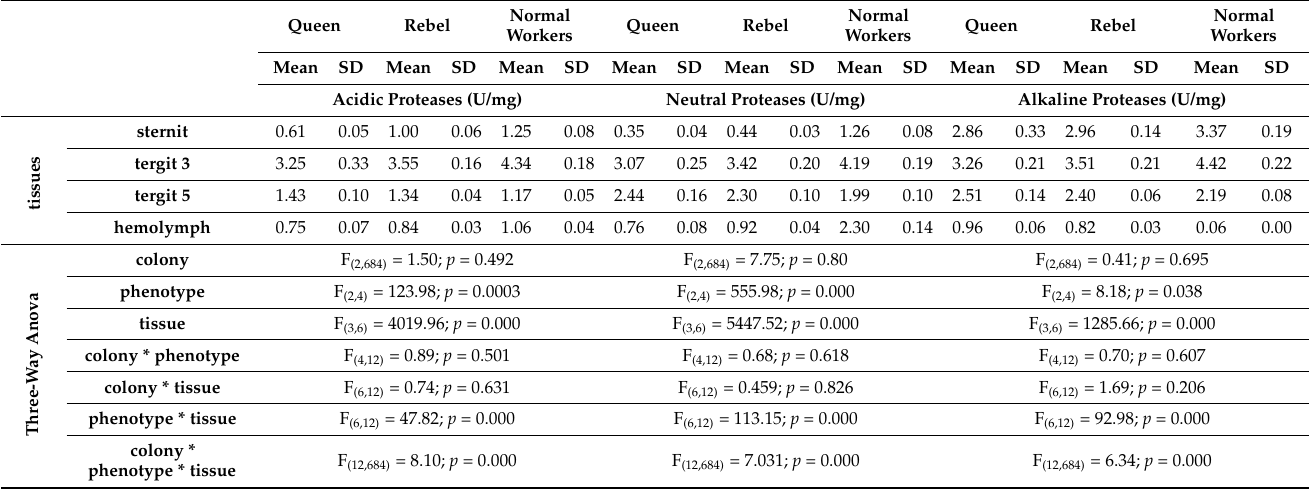
Table 1. Activities of the proteolytic system in the fat body and hemolymph of the A. mellifera queens, rebels, and normal (sterile non-rebel)